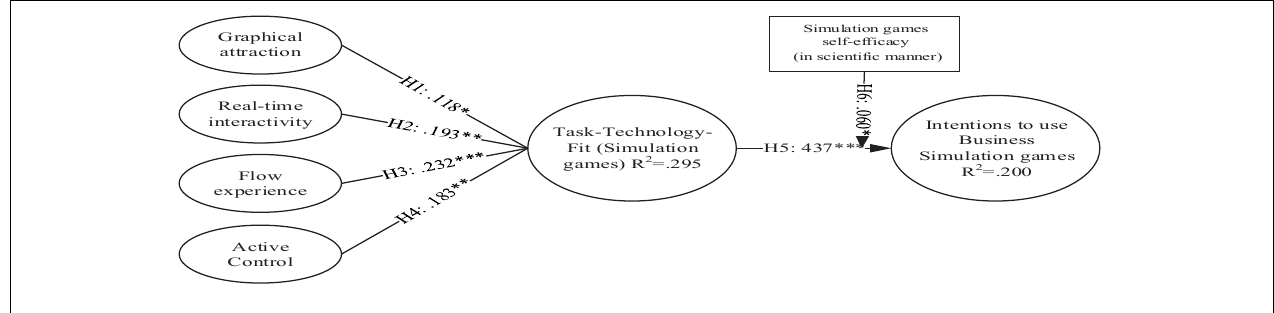
FIGURE 1 | Pictorial view of the proposed model. ∗∗∗ p < 0.001, ∗∗ p < 0.01, ∗ p < 0.05.